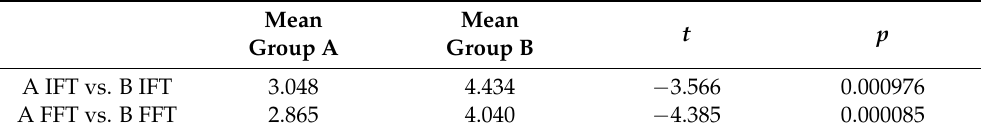
Table 6. Comparison of independent variables, mean delta values for IFT and FFT between groups A and B with Student’s t